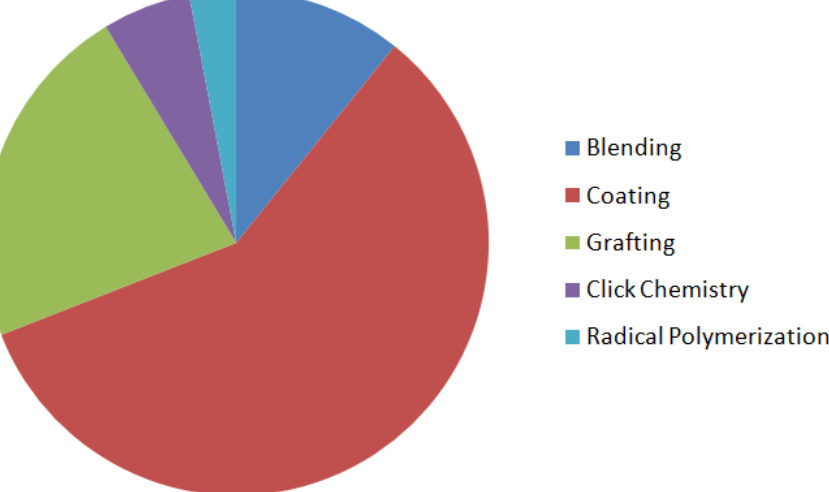
Figure 16. Statistical study of coating, blending, grafting, click chemistry, and radical polymerization for membrane surface modification in the last five years.